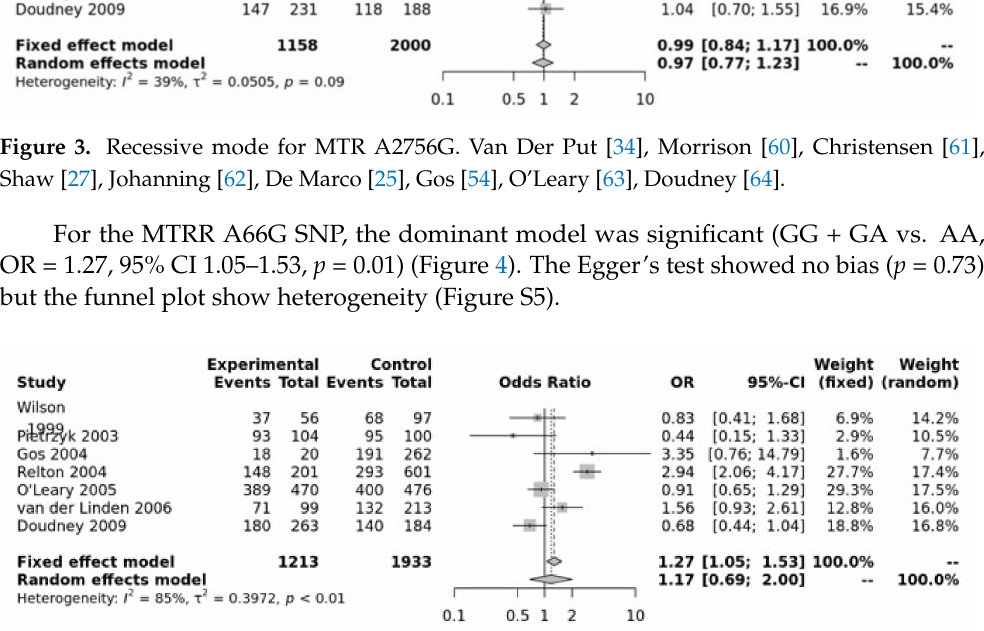
Figure 4. Association between MTRR A66G. Wilson [65], Pietrzyk [66], Gos [54], Relton [28], O’Leary [63], Van Der Linden [21], Doudney